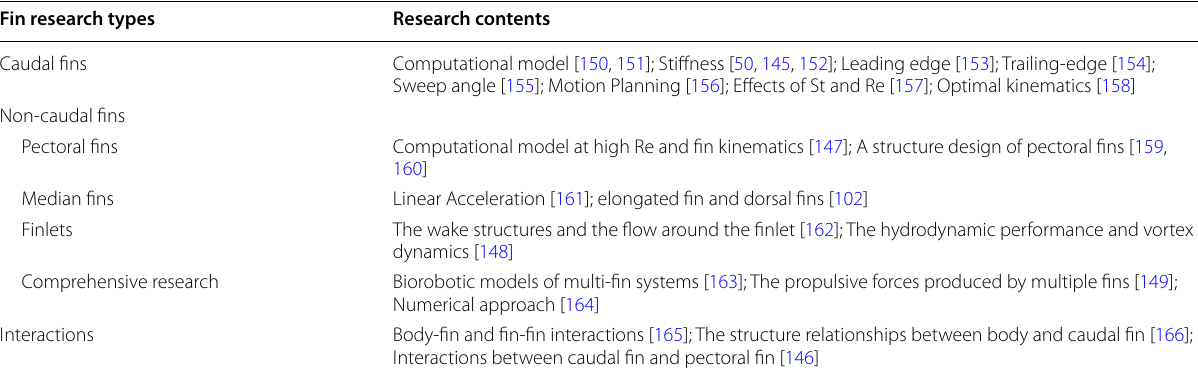
Table 3 Fin research types and corresponding contents